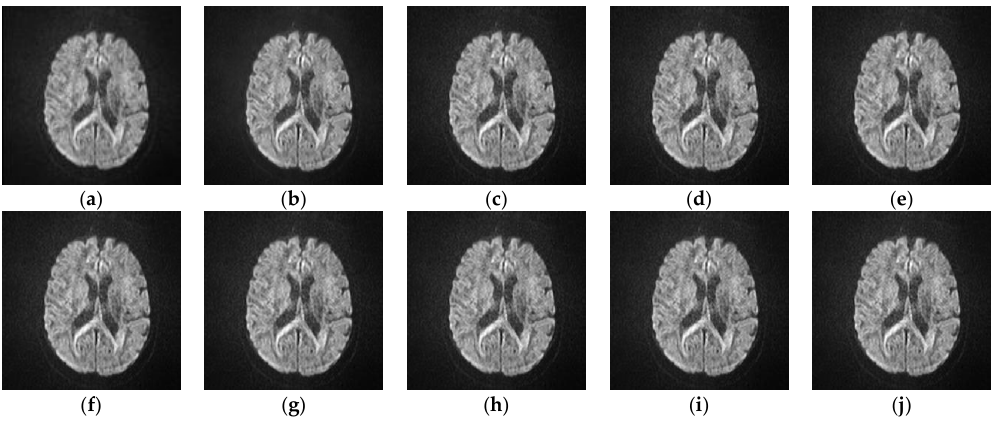
Figure 9. Comparison of the reconstructed images with different SR algorithms for medical image1 . ( a ) input; ( b ) L1SR; ( c ) SISR; ( d ) ANR; ( e ) NE + LS; ( f ) NE + NNLS; ( g ) NE + LLE; ( h ) A + (16 atoms); ( i ) ISPSR; ( j ) SRISAE.